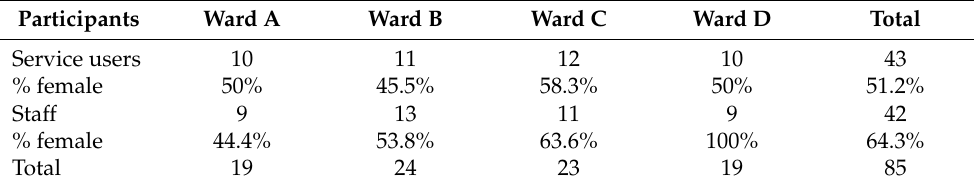
Table 1. Interview participant